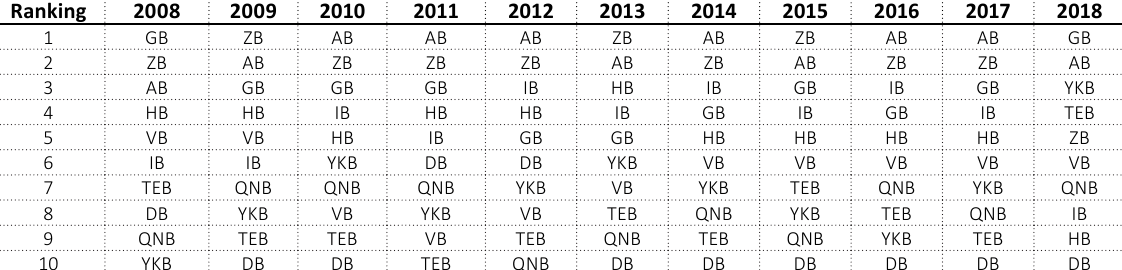
Table 5. Rankings of banks at the first stage Ranking